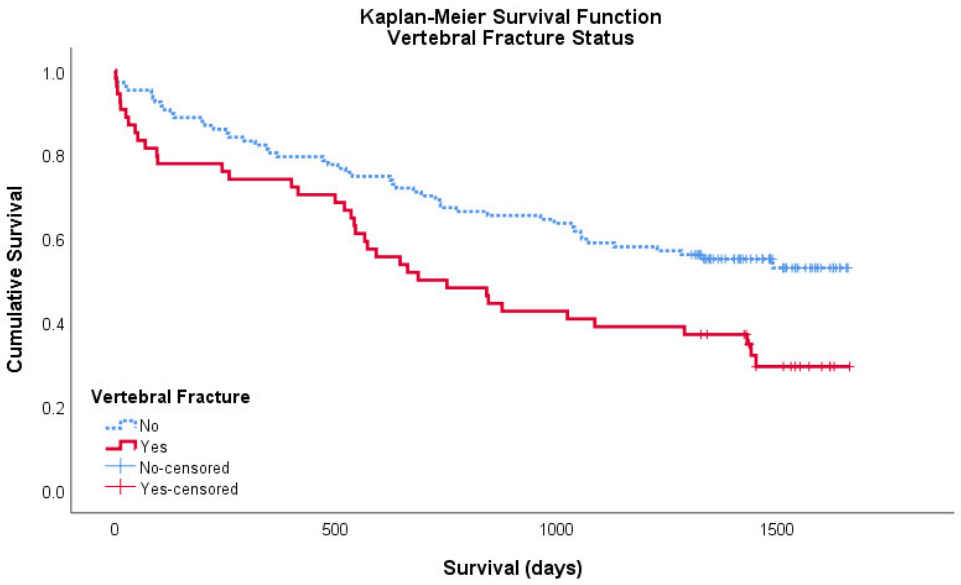
Figure 1. Kaplan–Meier survival curve showing the cumulative survival of patients with (red/solid) and without (blue/broken) a vertebral fracture on CTPA. Censored data is shown as ‘+’ in its respective colour.